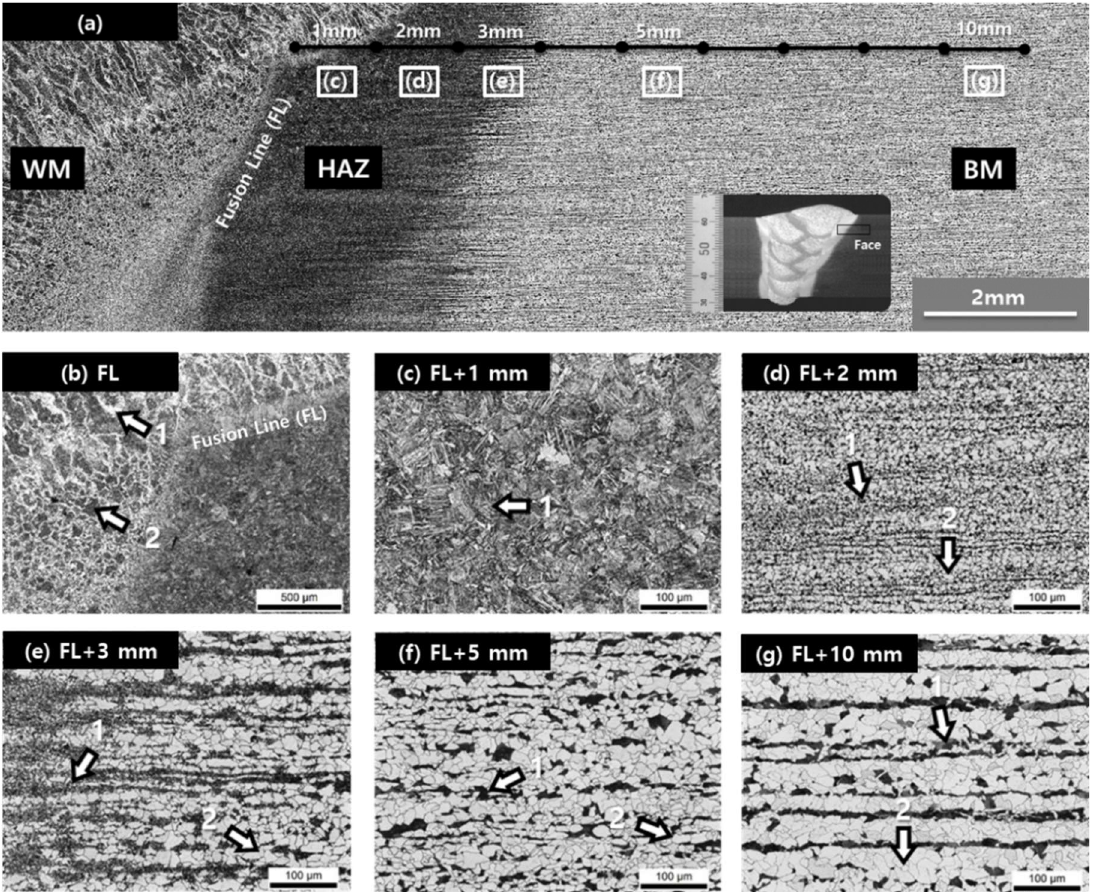
Figure 5. Optical micrographs of the weldment with a butt joint manufactured by FCAW on the 30 mm thick plate: ( a ) The weldment; ( b ) the fusion line: 1—grain boundary ferrite, 2—acicular ferrite; ( c ) fusion line + 1 mm: 1—upper bainite; ( d ) fusion line + 2 mm: 1—fine pearlite, 2—fine polygonal ferrite; ( e ) fusion line + 3 mm: 1—degenerated pearlite, 2—polygonal ferrite; ( f ) fusion line + 5 mm: 1—lamellar pearlite, 2—polygonal ferrite; ( g ) fusion line + 10 mm: 1—lamellar pearlite, 2—polygonal ferrite.